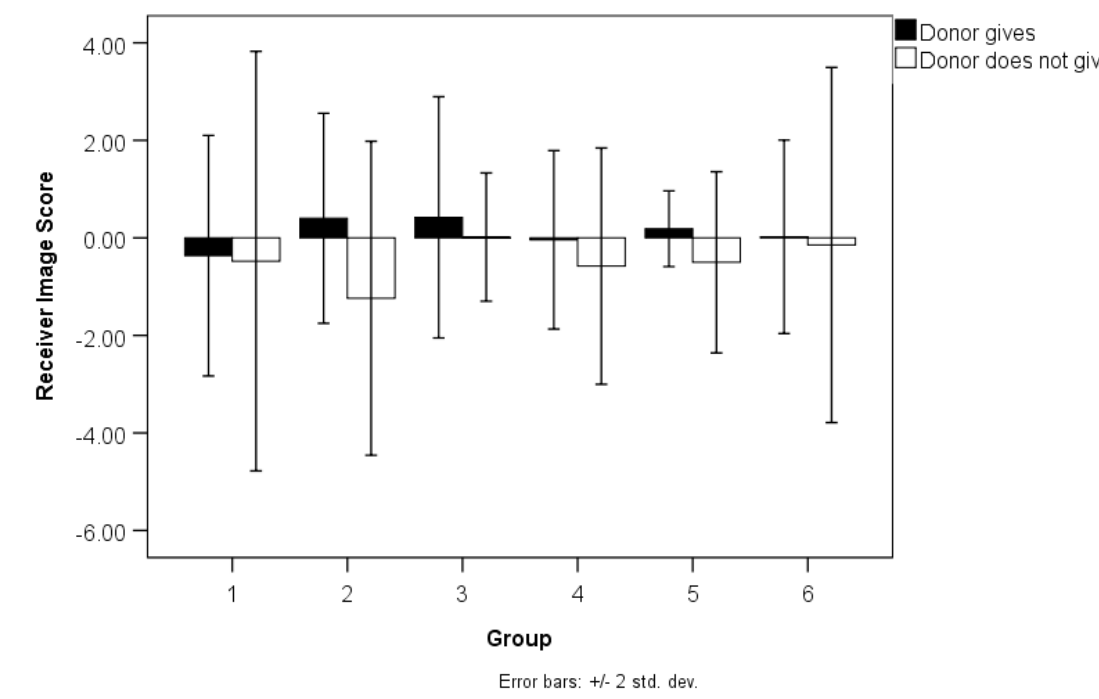
Figure 1. Image score of receivers when money given (black bars) or not (white bars).